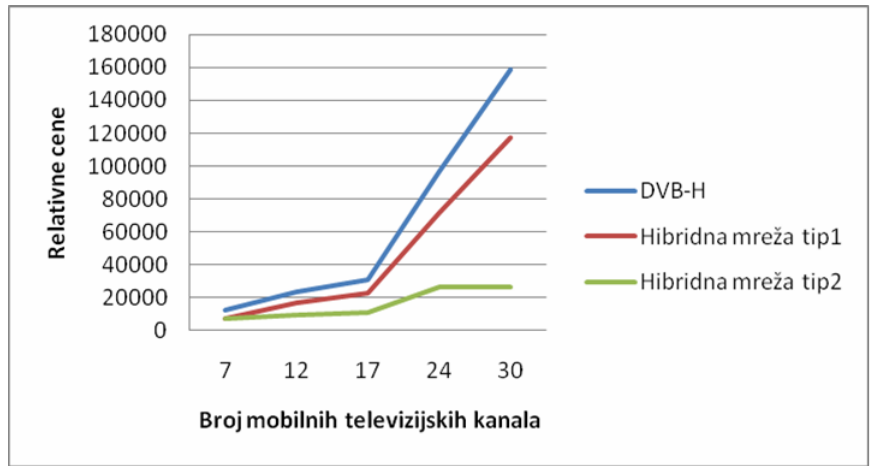
Figure 6 – Effects of the hybrid network realization mode on the costs of the mobile TV network